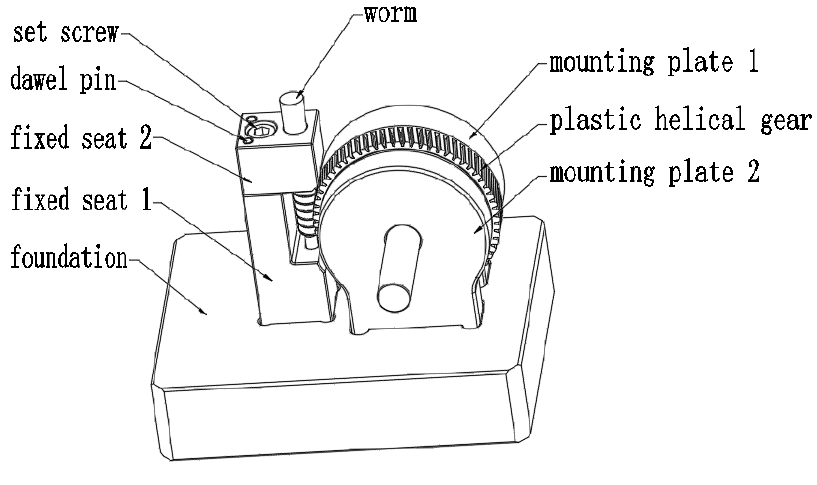
Figure 14. Test block.